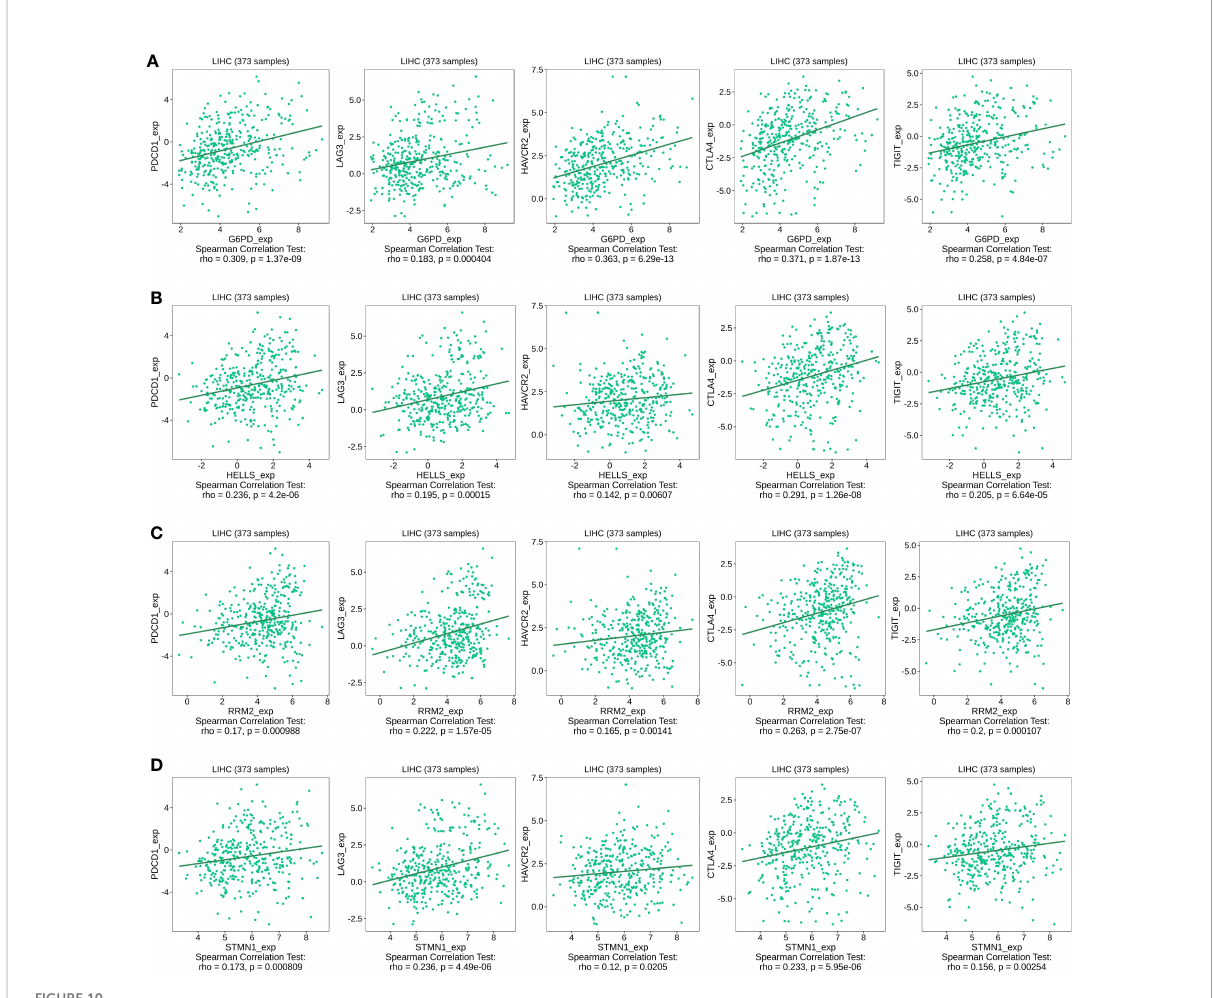
FIGURE 10 Correlation of four FRGs expression with immune checkpoint expression in HCC. (A) The expression correlation of G6PD with PDCD1, LAG3, HAVCR2, CTLA-4, and TIGIT expression in HCC was determined by the TISIDB database. (B) The expression correlation of HELLS with PDCD1, LAG3, HAVCR2, CTLA-4, and TIGIT expression in HCC was determined by the TISIDB database. (C) The expression correlation of RRM2 with PDCD1, LAG3, HAVCR2, CTLA-4, and TIGIT expression in HCC was determined by the TISIDB database. (D) The expression correlation of STMN1 with PDCD1, LAG3, HAVCR2, CTLA-4, and TIGIT expression in HCC was determined by the TISIDB